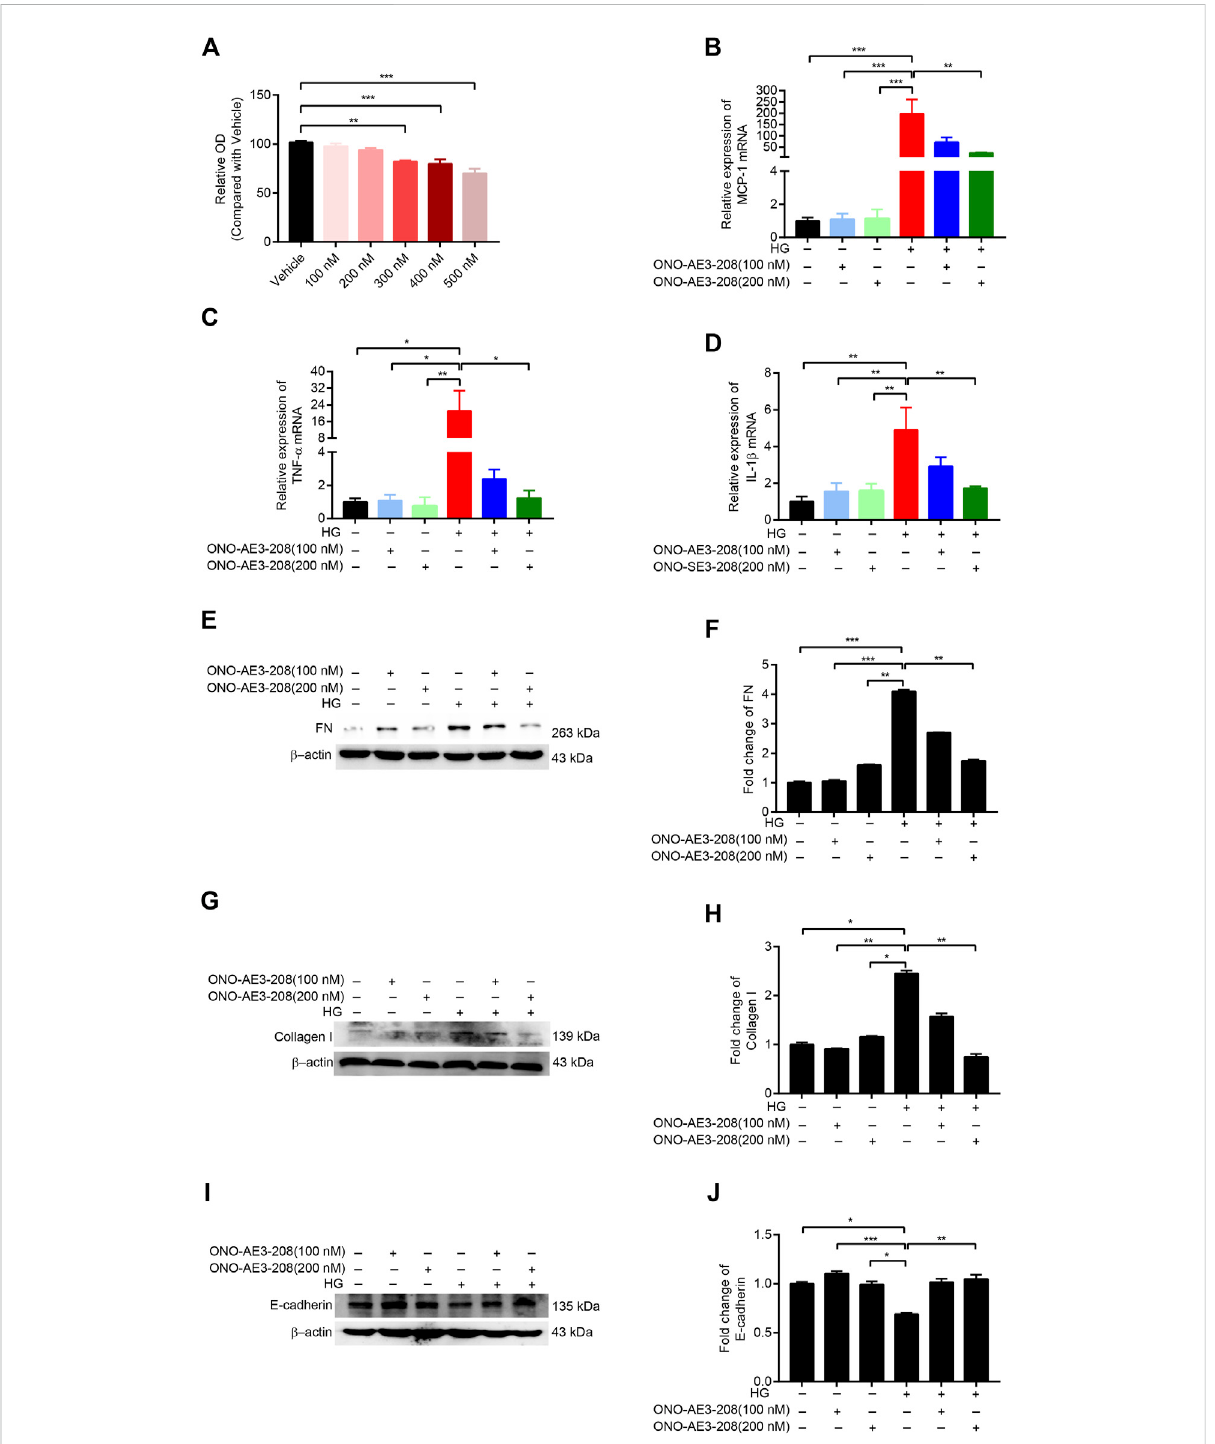
FIGURE 2 ONO-AE3-208 decreased in fl ammatory activity and synthesis of extracellular matrix in cultured RPMCs. (A) Cell viability from RPMCs treated with different doses of ONO-AE3-208 was examined by CCK-8. (B – D) Real-time quantitative PCR analysis of MCP-1, TNF- α , and IL-1 β levels in RPMCs exposed to different doses of ONO-AE3-208 or 138 mmol/L glucose. (E,G,I) Cell lysates from RPMCs treated with different doses of ONO- AE3-208 or 138 mmol/L glucose were subjected to western blotting analysis with speci fi c antibodies against fi bronectin (FN), collagen I, E-cadherin, and β -actin. (F,H,J) Expression levels of FN, collagen I, and E-cadherin were quanti fi ed by densitometry, normalised with β -actin, and presented as fold changes. Data are presented as mean ± SEM. * p < 0.05, ** p < 0.01, *** p <